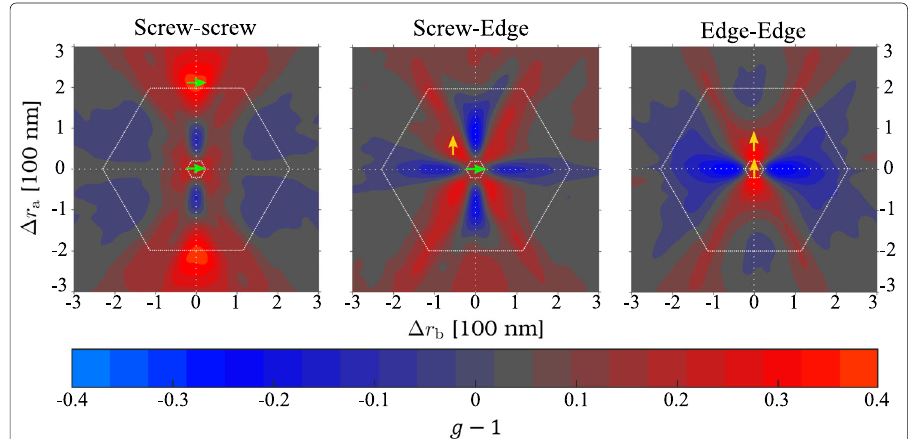
Fig. 4 The spatial form of the correlation functions corresponding to the screw-screw, screw-edge, and edge-edge components. Shown are correlation functions calculated at 0.3% strain and a convolution length of 164 nm. The x-axis represents the spatial direction parallel to screw dislocations, and the y-axis represents the spatial direction parallel to edge dislocations. The red regions are those separation distances for which ( r )ρ ( r + r ) tends to underestimate the two-point density, and the blue regions are those where the ρ i j two-point density is overestimated. This leads to a simple geometric interpretation in the case of the screw-screw and edge-edge components of the densities, but not so in the case of the screw-edge component. Rather than showing a simple circle with radius L as in Fig. 3, we here show the intersection of the plane in view ({111} type) with the support of w L (a cartesian